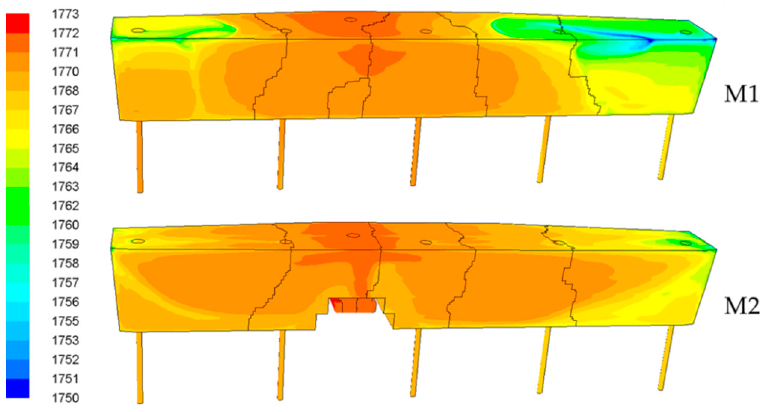
Figure 7. Comparison of a temperature field (in K) on the surface of the modelled area of the tundish for the configuration of the impact area M1 and M2.